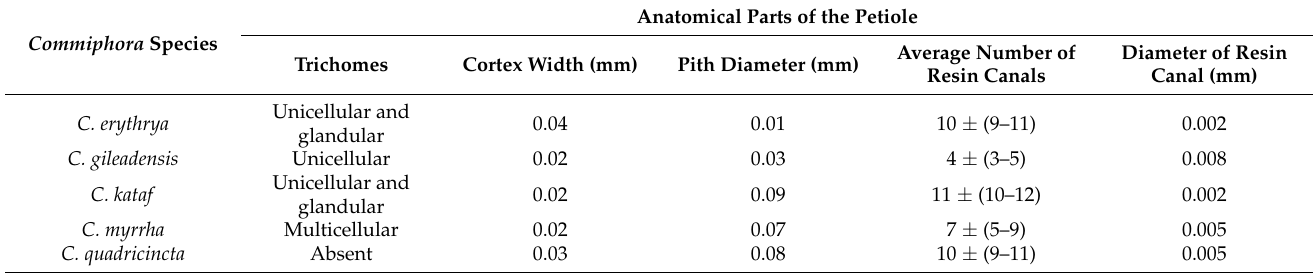
Figure 10. Transverse sections in leaf petioles of: ( A ) C. erythraea , ( B ) C. gileadensis , ( C ) C. kataf , ( D ) C. myrrha , and ( E ) C. quadricincta ; gh: glandular hair, ep: epidermis, co: cortex, ph: phloem, ri: risen canal, xy: xylem, pi: pith, bc: bundle cap. Table 4. Quantitative anatomical characters of petiole in Commiphora sp.